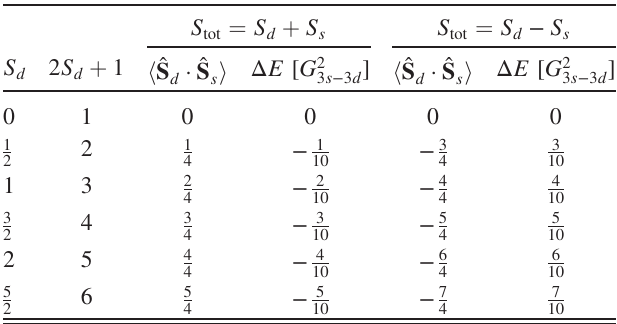
ˆ S ˆ S TABLE I. Eigenvalues of · , related to the energy configuration 6 A 1 are to the left of the gray vertical line, d s splitting due to the Coulomb interaction of pure spin multiplets and low-spin on the right. The size of each star is propor- (i.e., neglecting spin-orbit interaction) in the d shell with the tional to the intensity of the excitation, averaged over all open 3 s 1 core shell for states with the d spin either directions. There are only two states in the diagrams that ¼ S þ S ¼ S − S parallell ( S ) or antiparallell ( S ) to the d s d s tot tot core s spin.